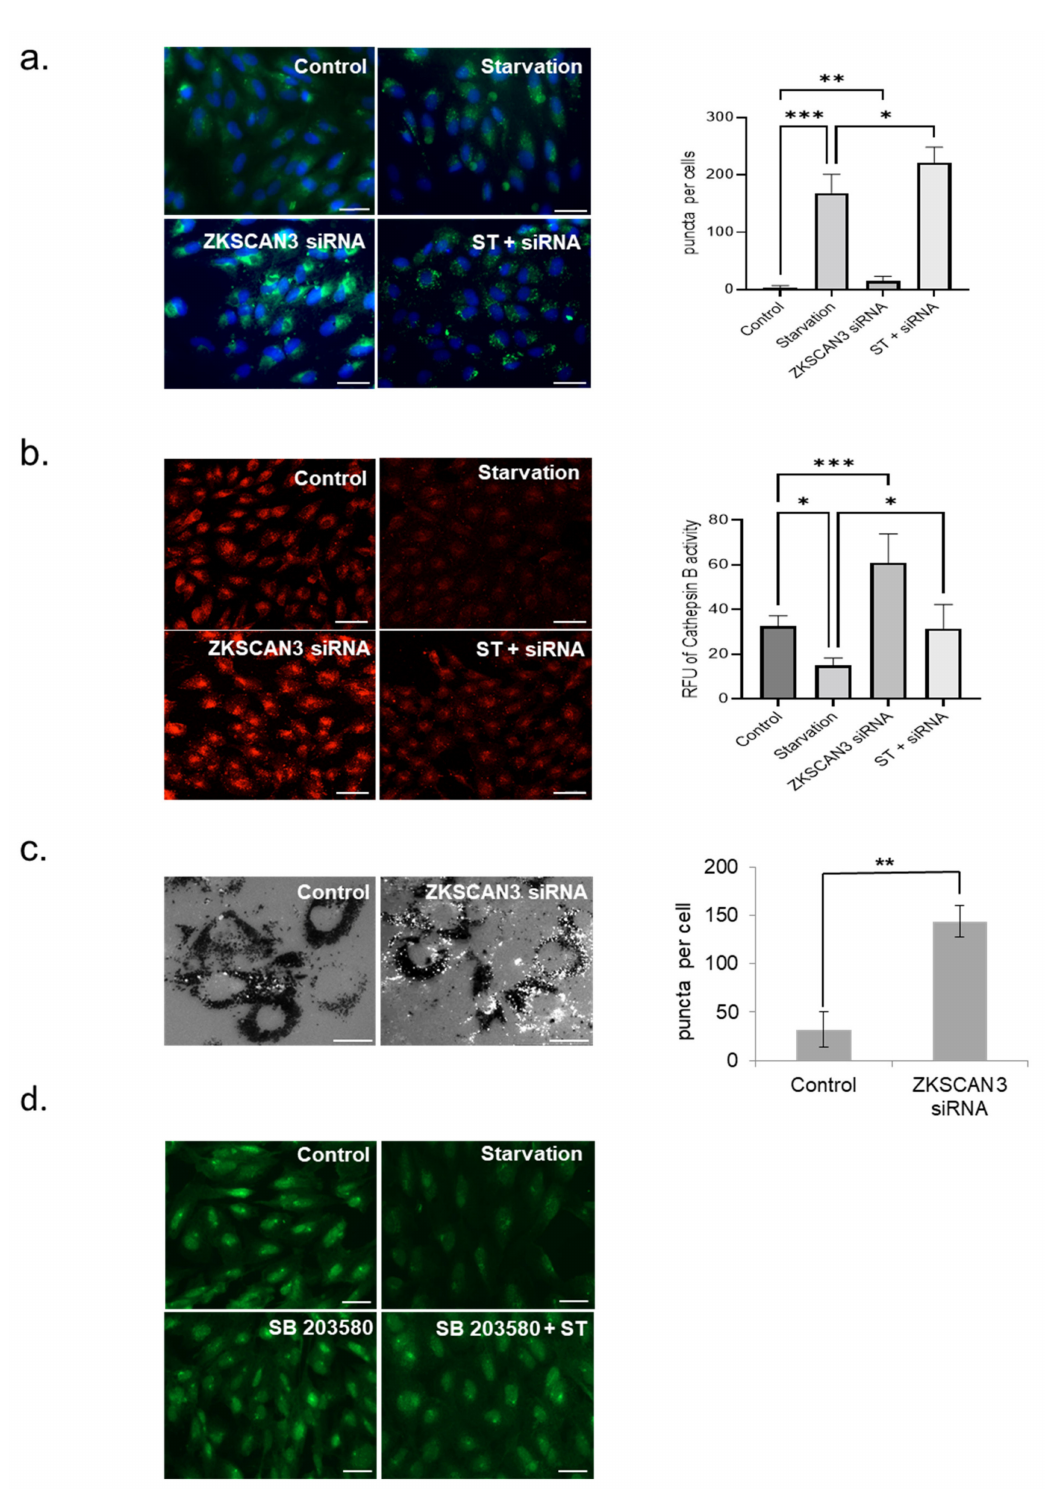
Figure 4. Knockdown of ZKSCAN3 induces lysosomal function in the RPE. ( a ) Staining with the LysoTracker dye in control and in cells ZKSCAN3 siRNA compared with control. Quantification of LysoTracker puncta using ImageJ software. Scale = 20 µ M. ( b ) Measurement of Cathepsin B activity using the magic red cathepsin B substrate upon knockdown of ZKSCAN3. Quantification of cathepsin B staining using ImageJ software. Scale = 40 µ M. ( c ) Staining with LysoTracker dye to evaluate lysosomal biogenesis in ABCA4 knockout RPE upon ZKSCAN3 siRNA knockdown for 48 h. Scale = 10 µ M. ( d ) ZKSCAN3 immunostaining in the presence of P38 MAPK inhibitor, SB203580. Scale = 20 µ M. All data are presented as mean ± standard deviation. One-way ANOVA and Student’s t -test (two tailed) were used for analysis p -value. The p -value is stated as * p < 0.05, ** p < 0.01, *** p < 0.001. (ST indicates